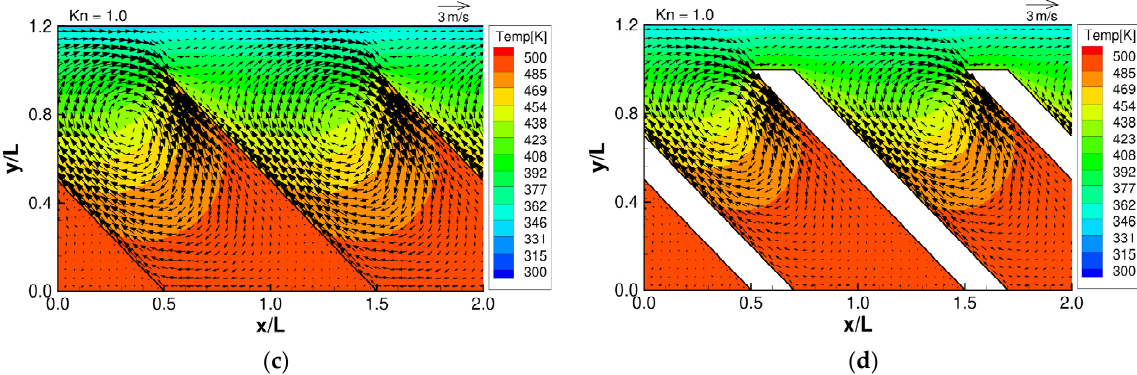
Figure 4. Flow distributions and temperature distributions for ( a ) ratchet, ( b ) modified ratchet, ( c ) oblique plate, and ( d ) oblique ridge, at Kn = 1.